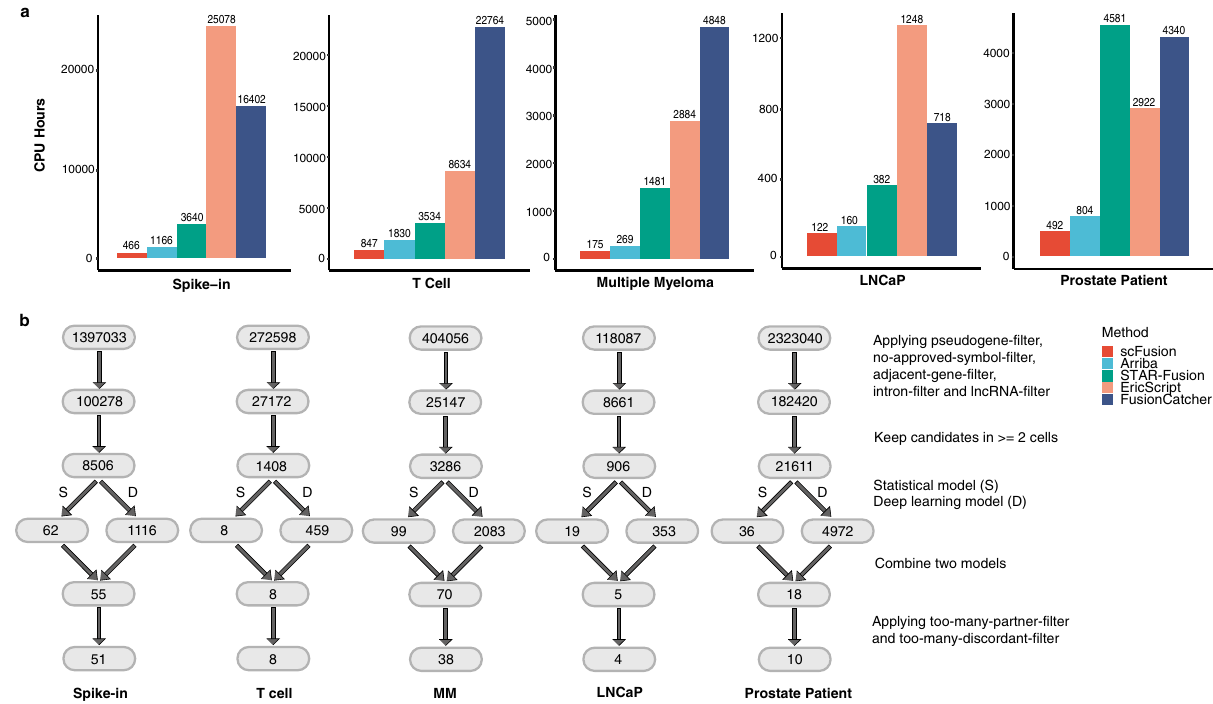
Fig. 4 The computational time and effects of scFusion ’ s fi lters. a The computational time of the fi ve methods for fusion detection in fi ve scRNA-seq data. The y -axis is the total CPU hours of each method. b Number of fusion candidates after each fi lter. The top is the total number of fusion candidates, and the second layer is the number of fusion candidates after excluding candidates involving pseudogenes, lncRNAs, genes without an approved symbol, and in intronic regions (they are called pseudogene-, lncRNA-, no-approved-symbol-, and intron- fi lters). The third layer is the number of candidates supported by at least 2 cells. The fourth layer shows the numbers of fusion candidates remained after the fi ltering by the statistical model and the deep-learning model, respectively. The fi fth layer is the number of candidates that pass both models. The last number indicates the number of output fusions after removing candidates with a partner gene involving in more than fi ve fusion candidates and candidates whose number of supporting discordant reads is ten times more than their supporting split-mapped reads (too-many-partner- and too-many-discordant- fi lters).